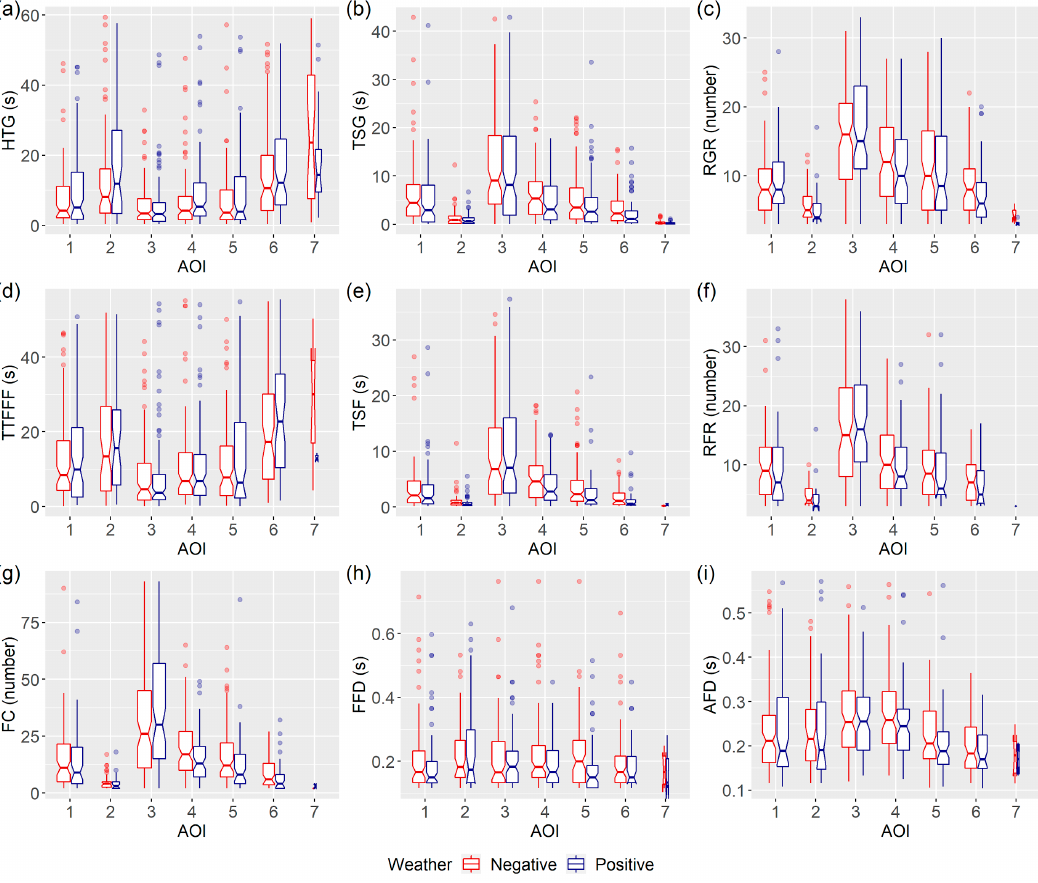
Figure 3. Statistic of chosen indexes: ( a ) HTG, ( b ) TSG, ( c ) RGR, ( d ) TTFFF, ( e ) TSF, ( f ) RFR, ( g ) FC, ( h ) FFD, ( i ) AFD (detailed description of indexes in the research area, data and methods chapter) for particular AOI in negative and positive weather for all respondents. On the boxplot, the middle values denote medians, the box extends to the Q1 (first quartile) and Q3 (third quartile), and the whiskers show the range of 99.3%: the upper whisker shows Q3 + 1.5 IQR (the interquartile range), the lower shows Q1 – 1.5 IQR. The notches extend to ± 1.58 IQR/sqrt(n) and show the 95% confidence intervals. Strong evidence of differing medians is indicated by non-overlapping notches.